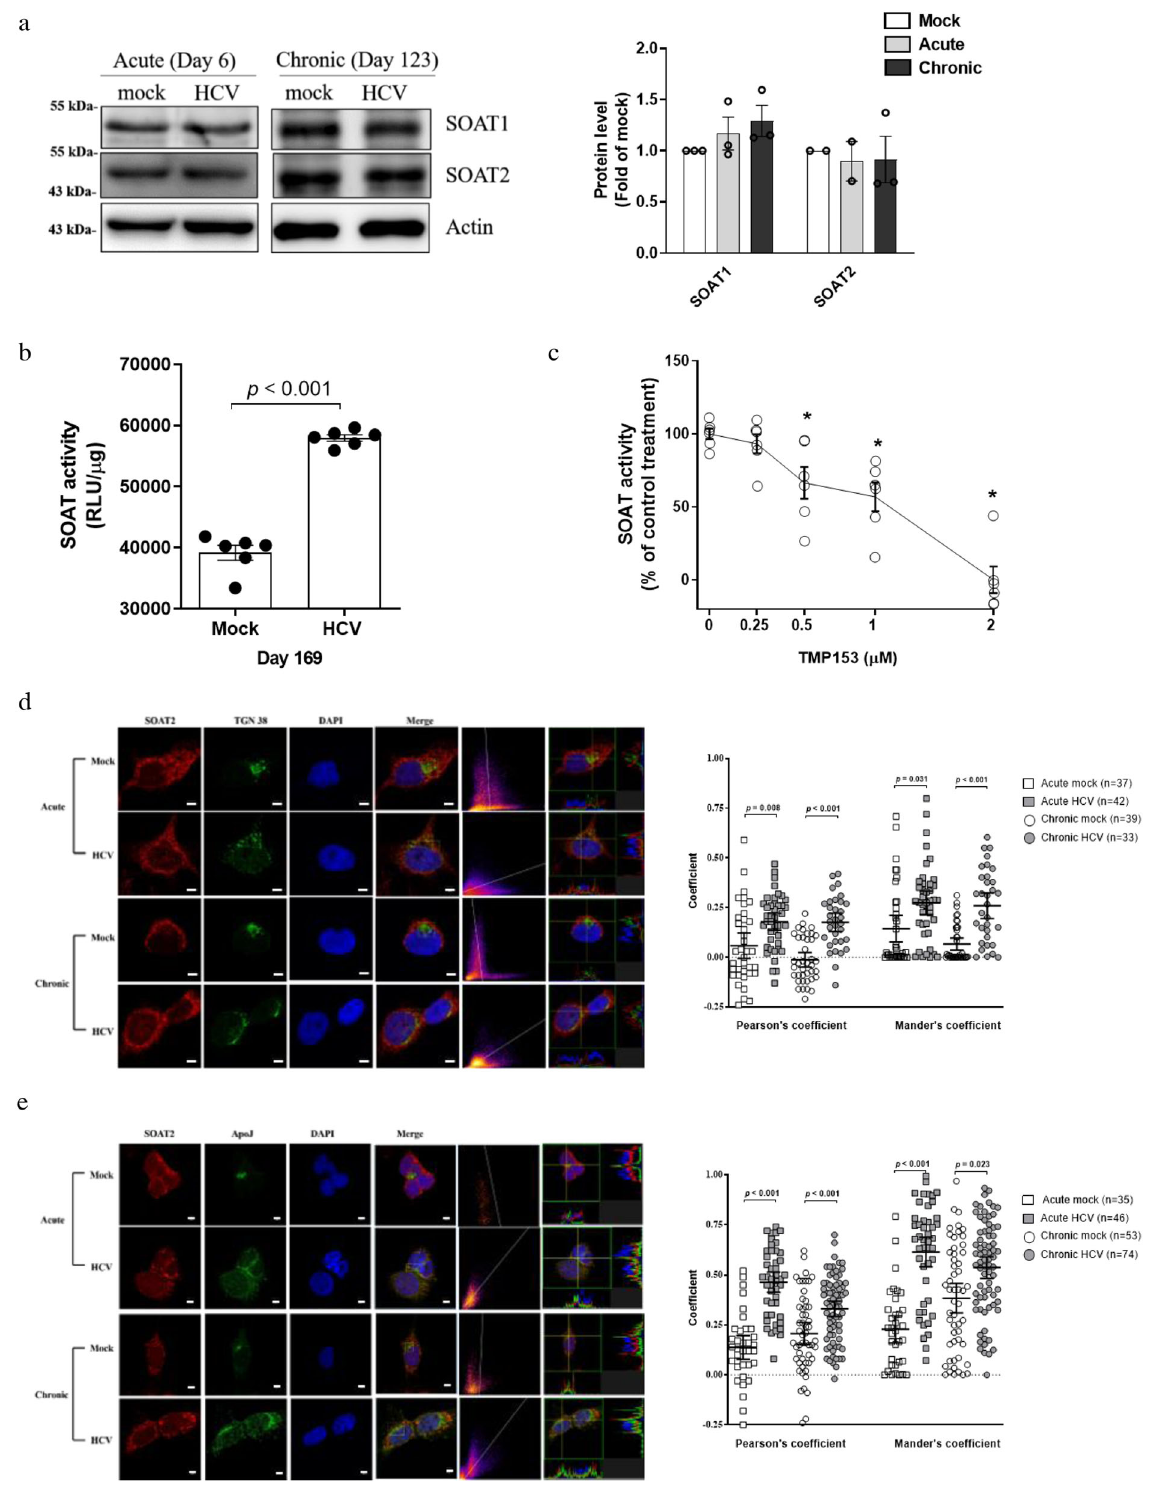
Fig. 2 HCV infection induced the co-localization of ApoJ with SOAT2 and elevated SOAT activity in the context of Golgi dispersion. a Protein levels of SOAT1 and SOAT2 in Huh7.5 cells with acute or chronic HCV infections, with the intensities shown in the right panel ( n ≧ 2). b HCV-infected Huh7.5 cells were fed with NBD-Chol, and the SOAT activity was evaluated ( n = 6). c HCV-infected Huh7.5 cells were treated with 0.25 – 2 μ M TMP153 for 16 h and the SOAT activity was quanti fi ed as in b . The asterisk indicates statistical signi fi cance ( p < 0.05) as compared to the untreated control. d Representative IFA images of SOAT2 (red) and Golgi (TGN38, green) in HCV-infected cells. The scatter plots of red and green channels, as shown at the right of the merged image, and the Pearson ’ s and Mander ’ s colocalization coef fi cients were analysed by the Coloc2 plugin from ImageJ/Fiji (ImageJ-Fiji-ImgLib http:// fi ji.sc/), respectively, as shown in the right panel. The fl uorescence intensity pro fi le across the arrow for both channels was analysed by FVW31S software. e Representative IFA images of SOAT2 (red) and ApoJ (green) analysed as in d . Scale bar, 5 μ m.